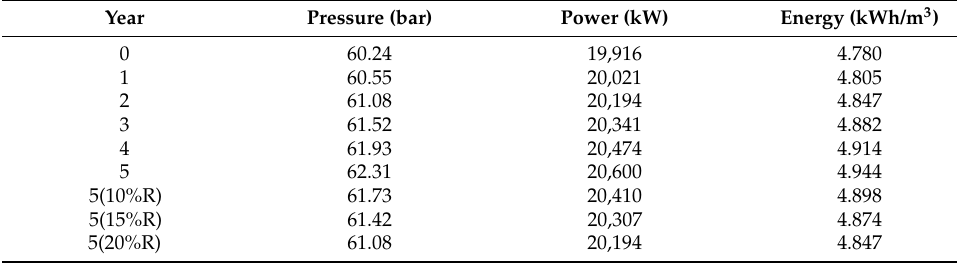
Table 5. Pressure, Power, and Energy consumption at 17 ◦ C.